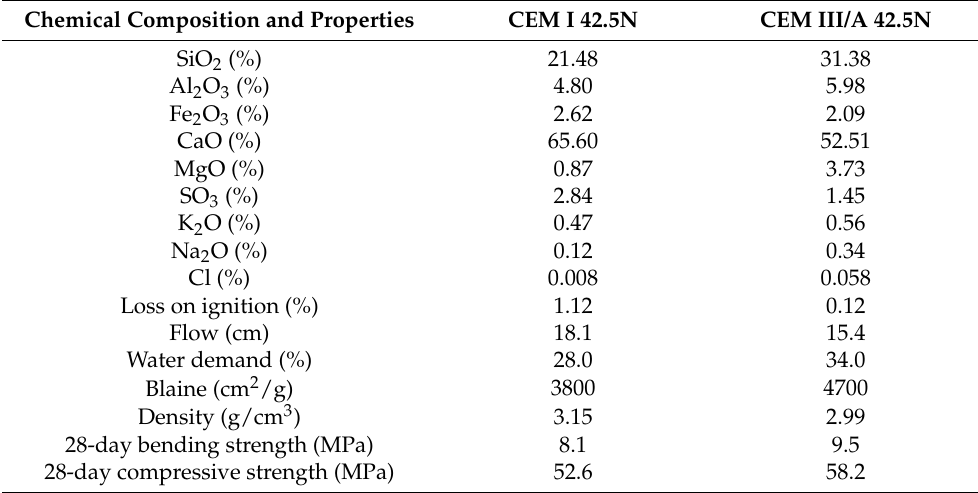
Table 1. Chemical compositions, physical properties, and strength of both types of cement [10]. Chemical Composition and